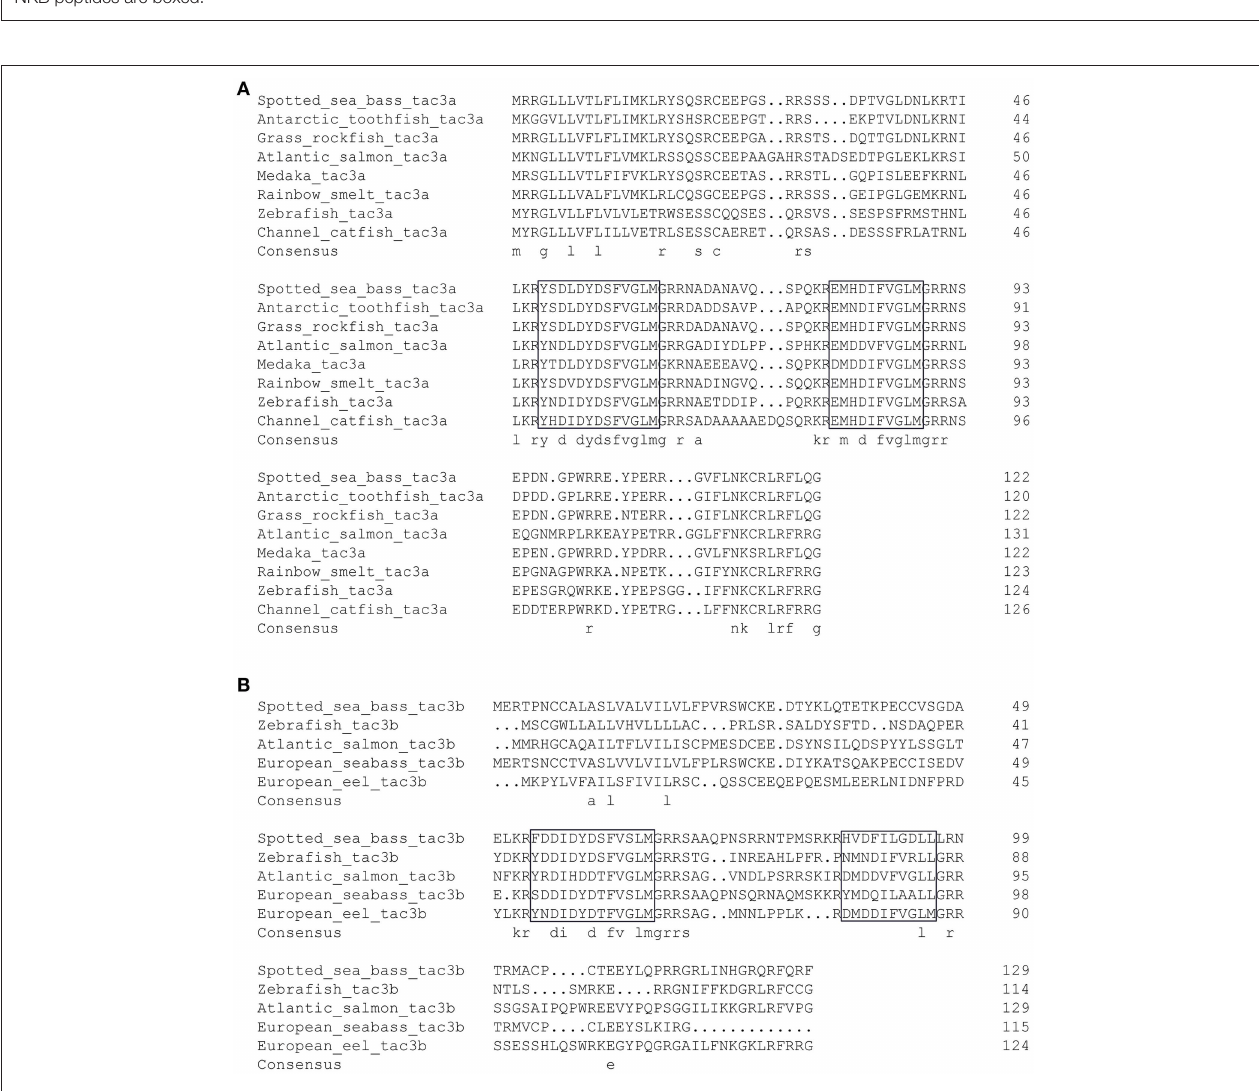
FIGURE 3 | Comparison of the amino acid sequences of spotted sea bass tac3a (A) and tac3b (B) precursors from different species. The boxed letters indicate the sequence of mature NKB peptides in the detected species.